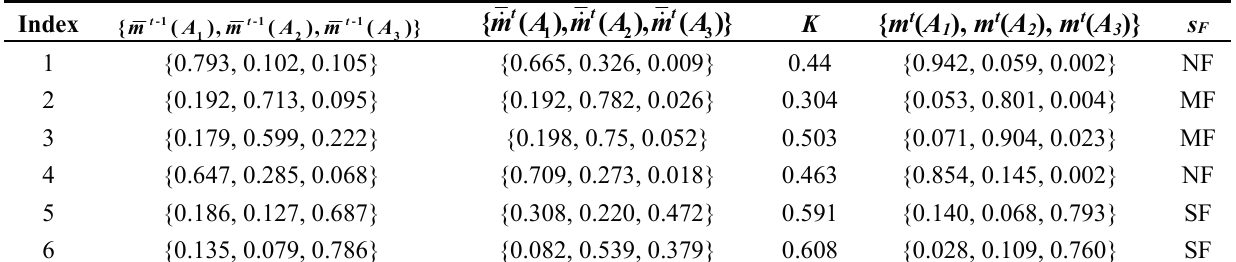
Table 8. Recognition results of decision-level